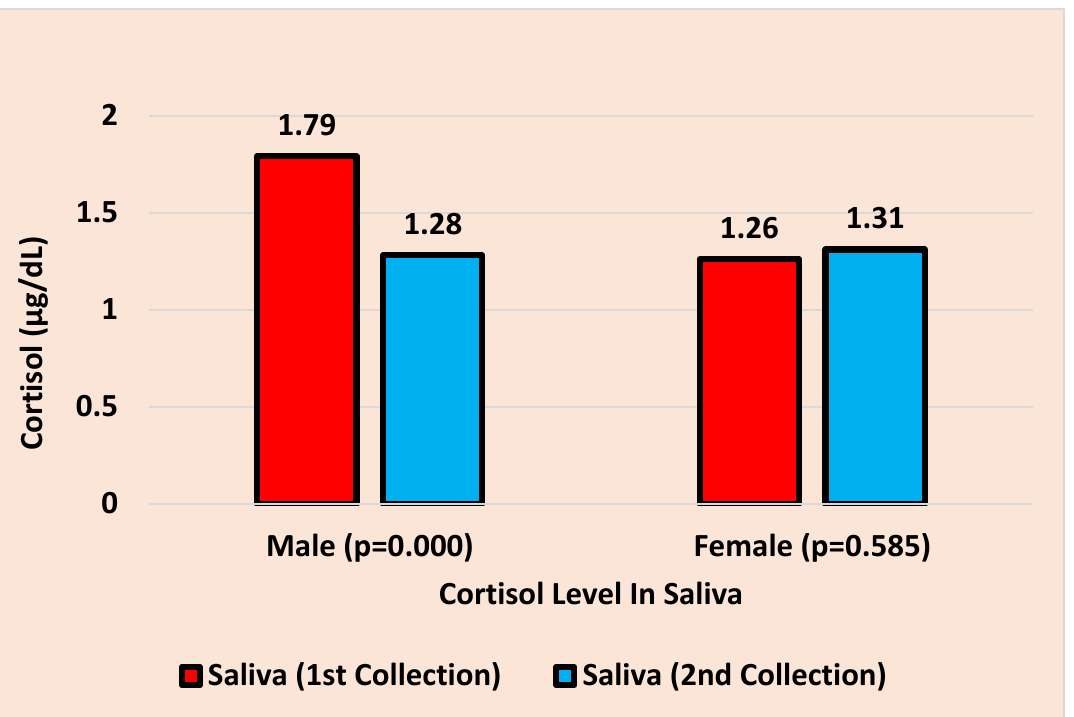
Figure 3. Gender wise comparison of cortisol levels in saliva for the participating students (N-151). The comparison of the mean cortisol levels in hair samples taken from the participating students at two distinct time points is shown in Table 2. At the first and second visits, the mean and standard deviation of the cortisol levels were 1.21 + 0.78 and 0.78 + 0.61, respectively. The comparisons between the cortisol levels at the two time intervals showed a significant difference ( p =